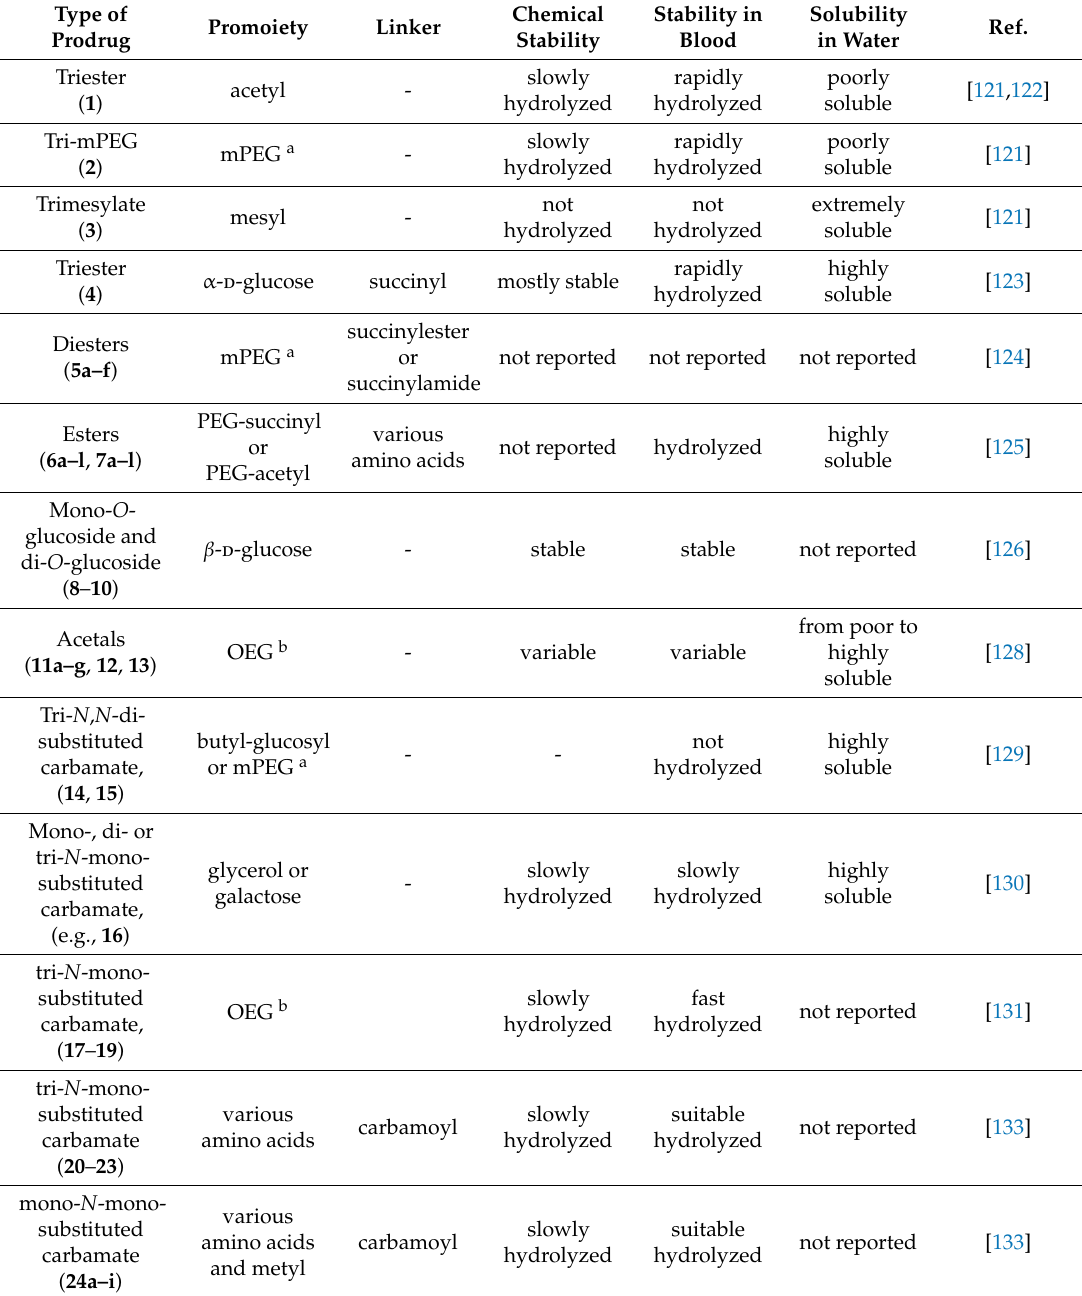
Table 5. Summary of RSV prodrugs for systemic delivery and their stability